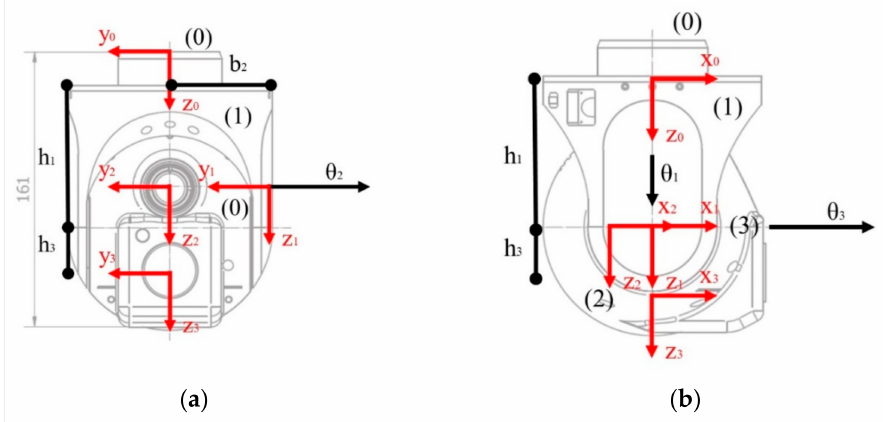
Figure 1. Proposed spherical gimbal: ( a ) side view and ( b ) front